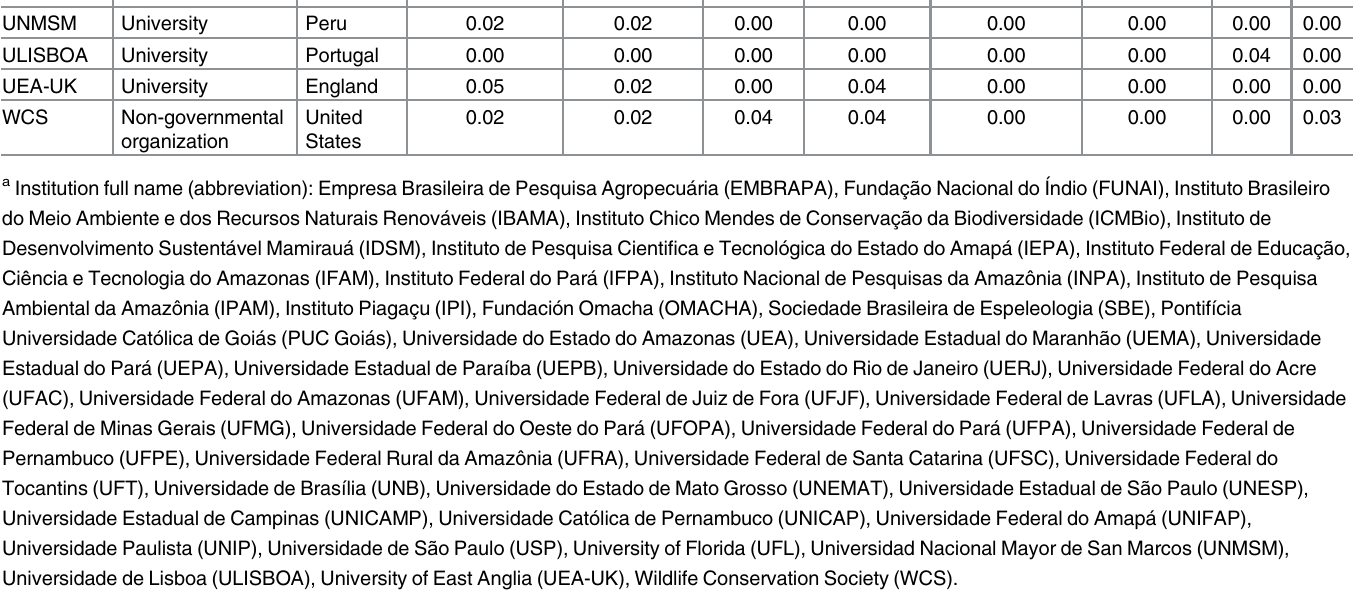
S1 Table. List of 105 studies on the subsistence and/or commercial hunting of Amazonian aquatic vertebrates. S2 Table. List of research institutes/universities that conducted studies on Amazonian aquatic